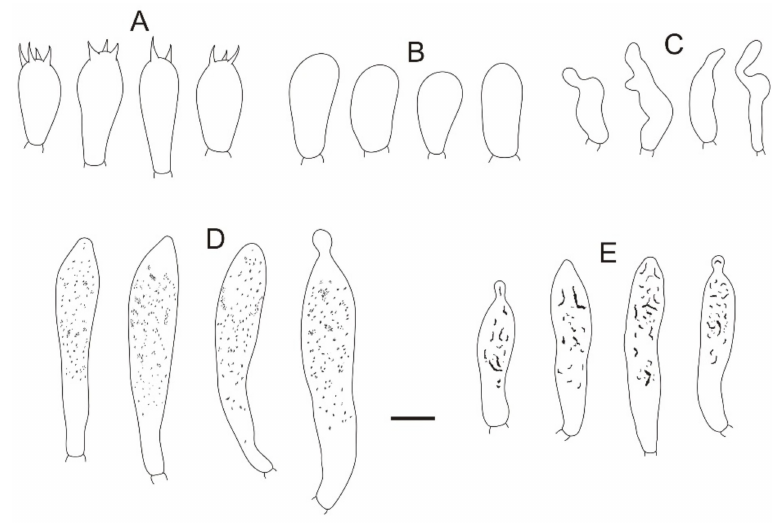
Figure 8. Microscopic features of Russula plana (BJTC Z1398). ( A ) Basidia. ( B ) Basidiola. ( C ) Marginal cells. ( D ) Hymenial cystidia on lamellae sides. ( E ) Hymenial cystidia on lamellae edges. Scale bar: 10 µ m.